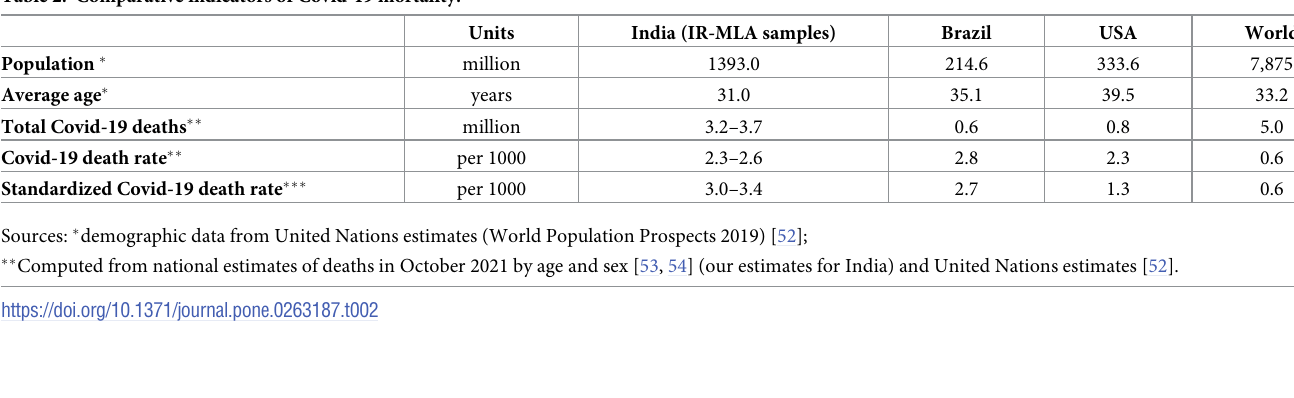
Table 2. Comparative indicators of Covid-19